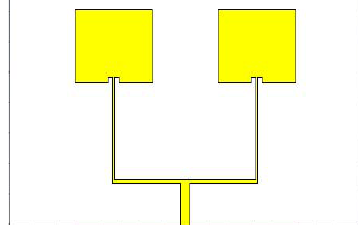
Figure 2: 2x1 patch antenna array schematic